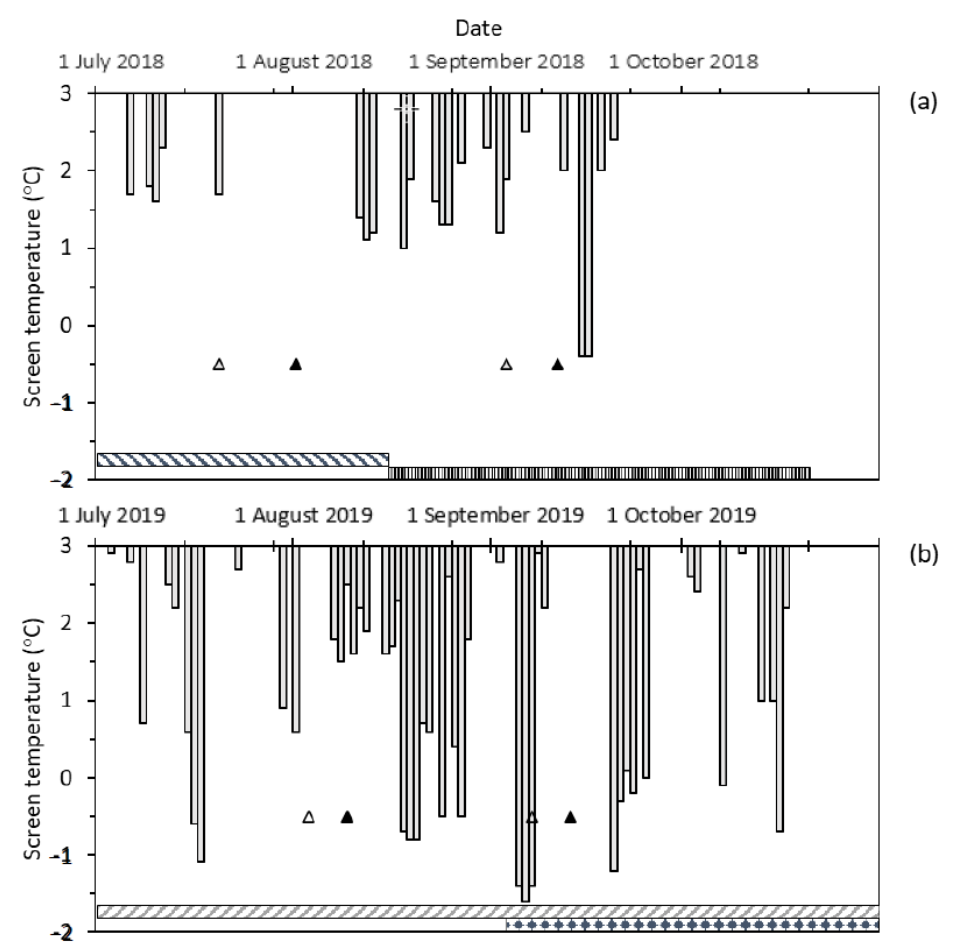
Figure 4. The timing of heading (Z55 open triangles) and anthesis dates (Z65 black triangles) for Wyalkatchem with frost events (screen temperatures ≤ 2 °C, 1200 mm above ground level) measured by an onsite weather station (Campbell Scientific) at Dale from July to October 2018 ( a ) and 2019 ( b ). The horizontal textured bars show the period during which the plot heaters were in place. Sowing dates for the corresponding heading and anthesis dates are: mid − April, 12 April 2018 and early